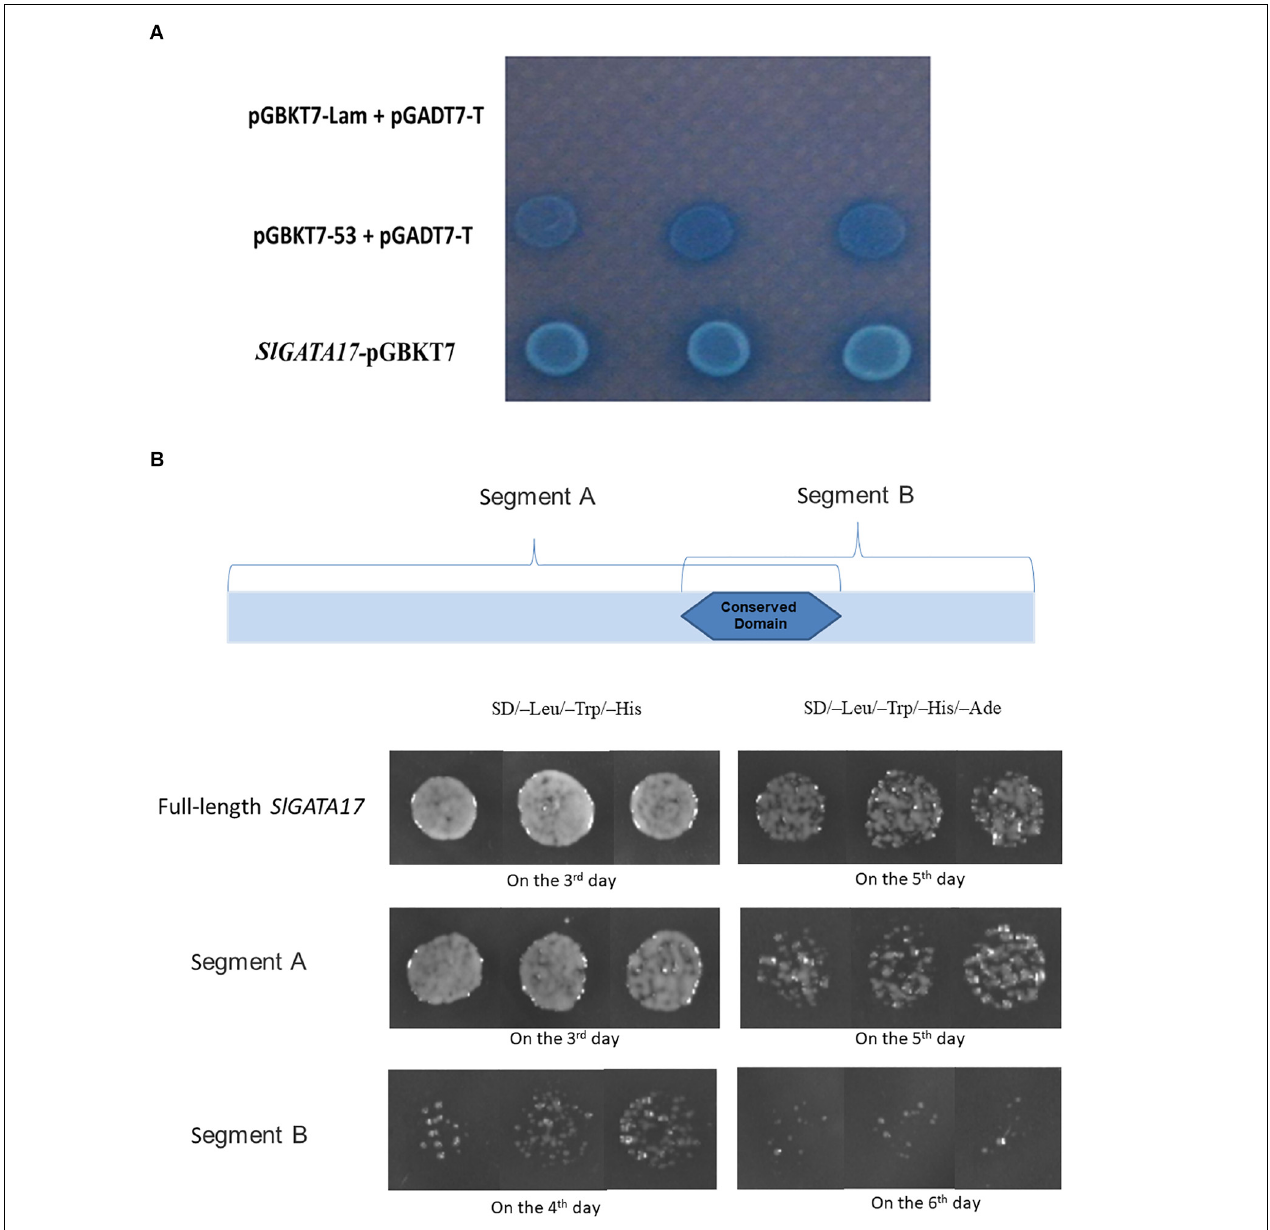
FIGURE 3 | (A) Results of transformant growth on SD/–Leu/–Trp/–His with X- α -Gal medium. SlGATA17 showed transcriptional activation activity. (B) Full length, segment A and segment B of SlGATA17 transformants grown on SD/–Leu/–Trp/–His and SD/–Leu/–Trp/–His–Ade media. The picture shows that the transcriptional activation activity of segment A was stronger than that of segment